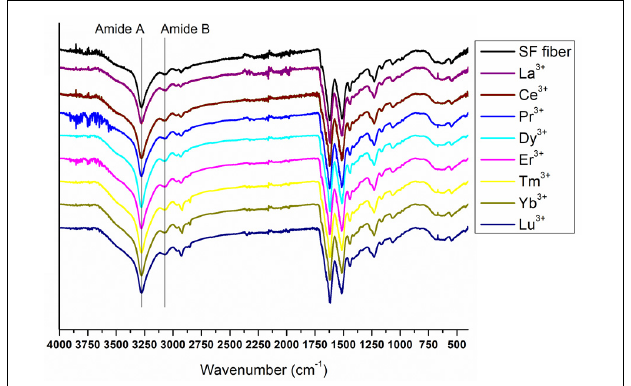
FIGURE 7 | Complete ATR-FTIR spectra of solid degummed SF (black curve) and regenerated solid Ln + 3 /SF (La + 3 /SF, Ce + 3 /SF, Pr + 3 /SF, Dy + 3 /SF, Er + 3 /SF, Tm + 3 /SF, Yb + 3 /SF, and Lu + 3